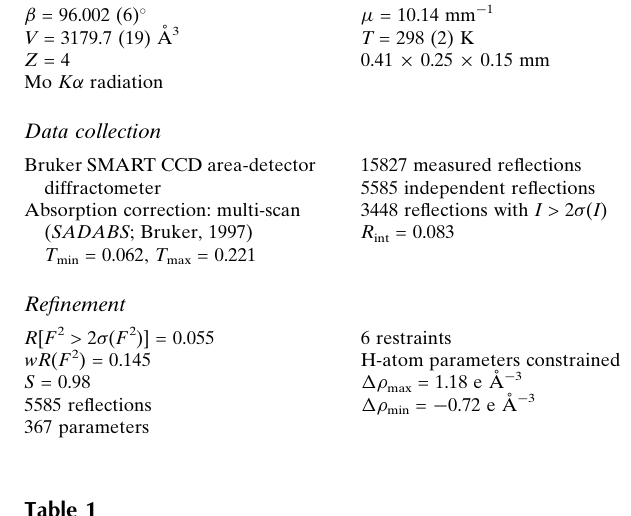
Hydrogen-bond geometry (A˚ , (cid:3) ). D —H (cid:1)(cid:1)(cid:1)